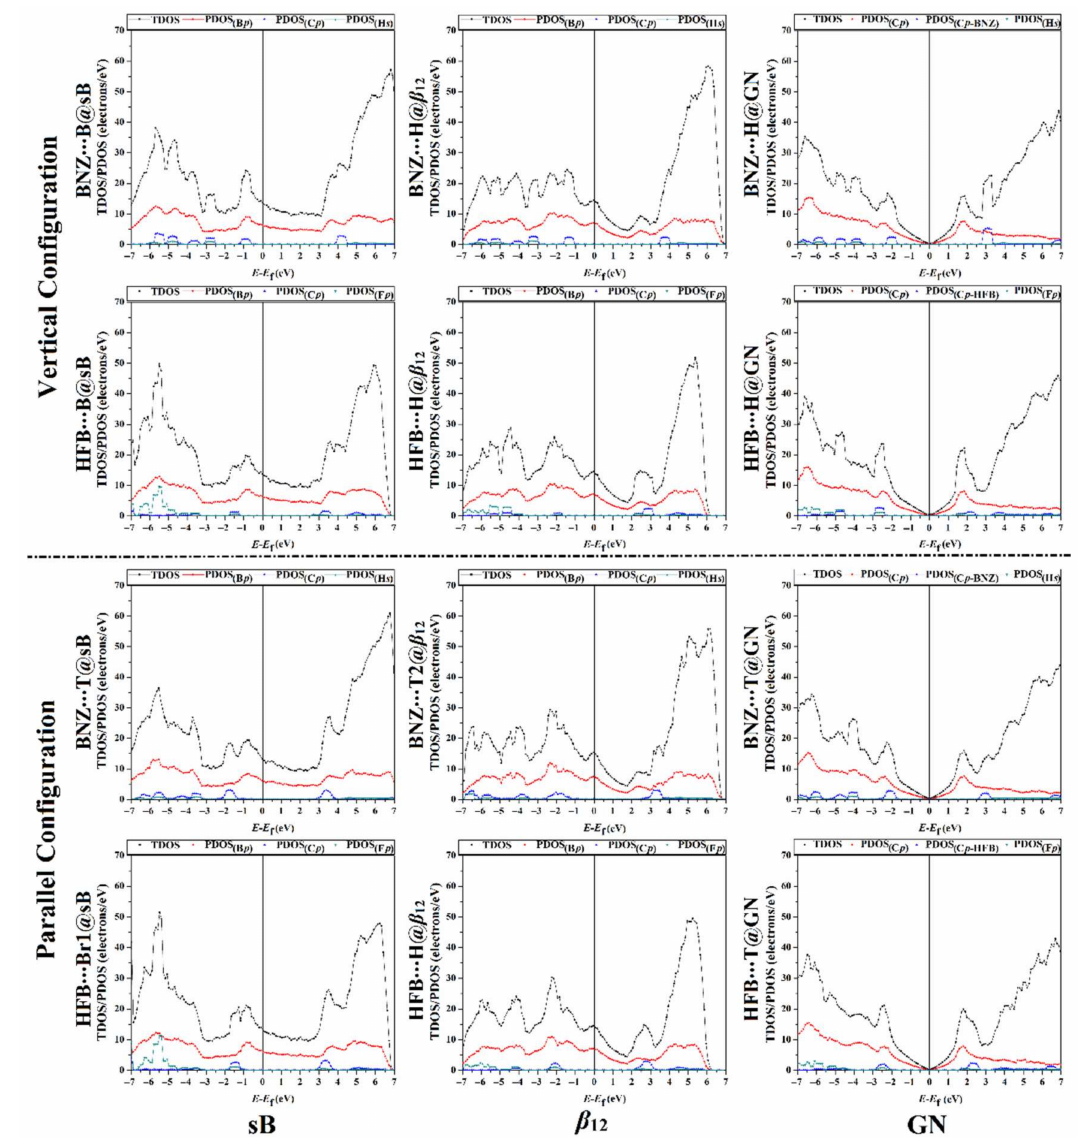
Figure 8. The total and projected density-of-states (TDOS/PDOS) plots for the sB, β 12 , and GN after the adsorption process of BNZ and HFB at the most energetically favorable adsorption sites in the vertical and parallel configurations. The B p /C p /F p and H s represent the p -orbital and s -orbital of boron (B)/carbon (C)/fluorine (F) and hydrogen (H) atoms,